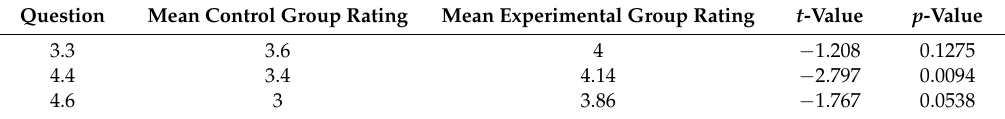
Table 8. Comparison of statistical significance of autonomy-focused survey questions.